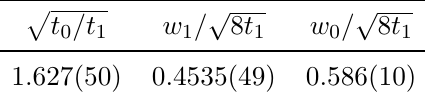
Table 3. Different scales determined from the flow expressed in units of √ 8 t w w 1 ( 0 ) are derived respectively from eqs. (5.3) and (5.4) setting